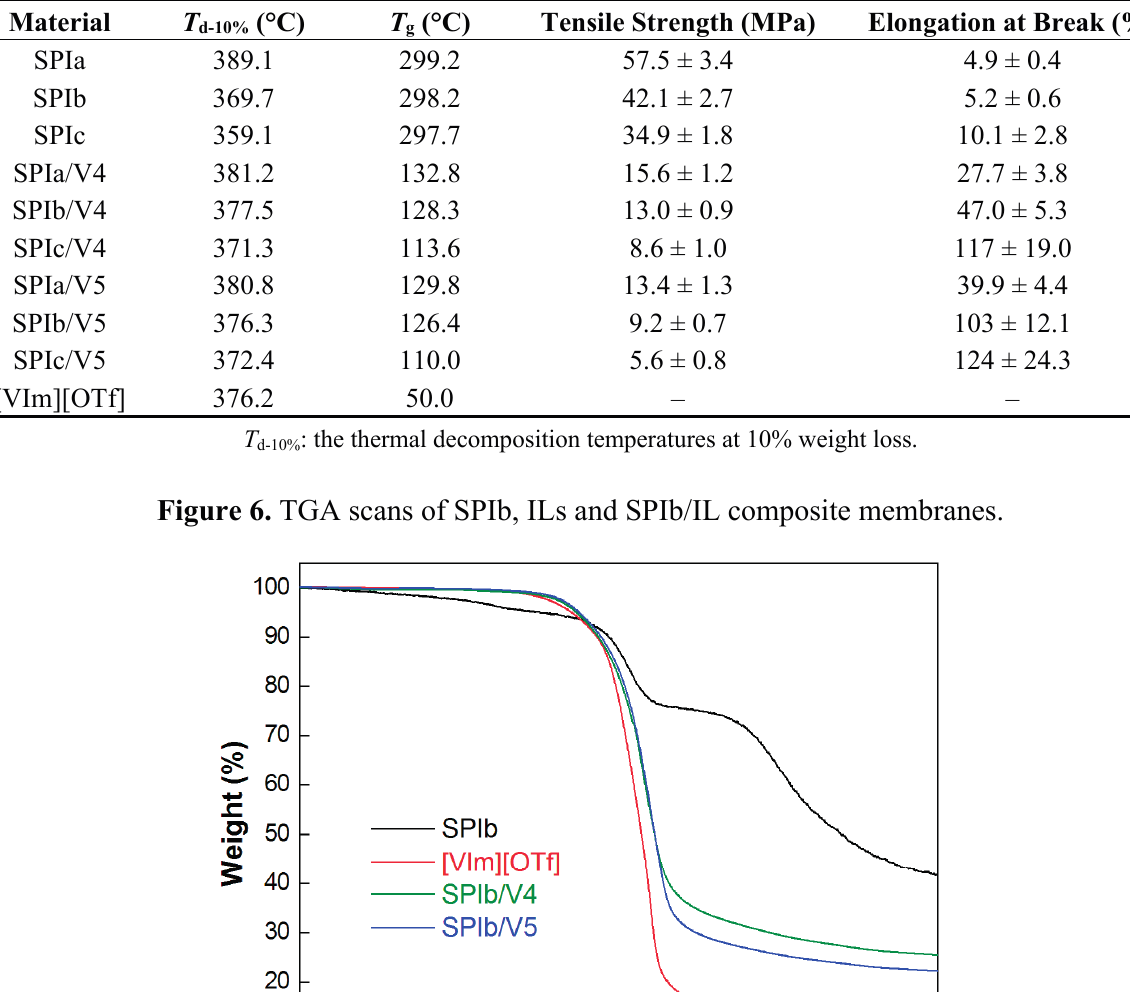
Table 4. Thermal and mechanical properties of SPIs, IL and SPI/IL composite membranes.